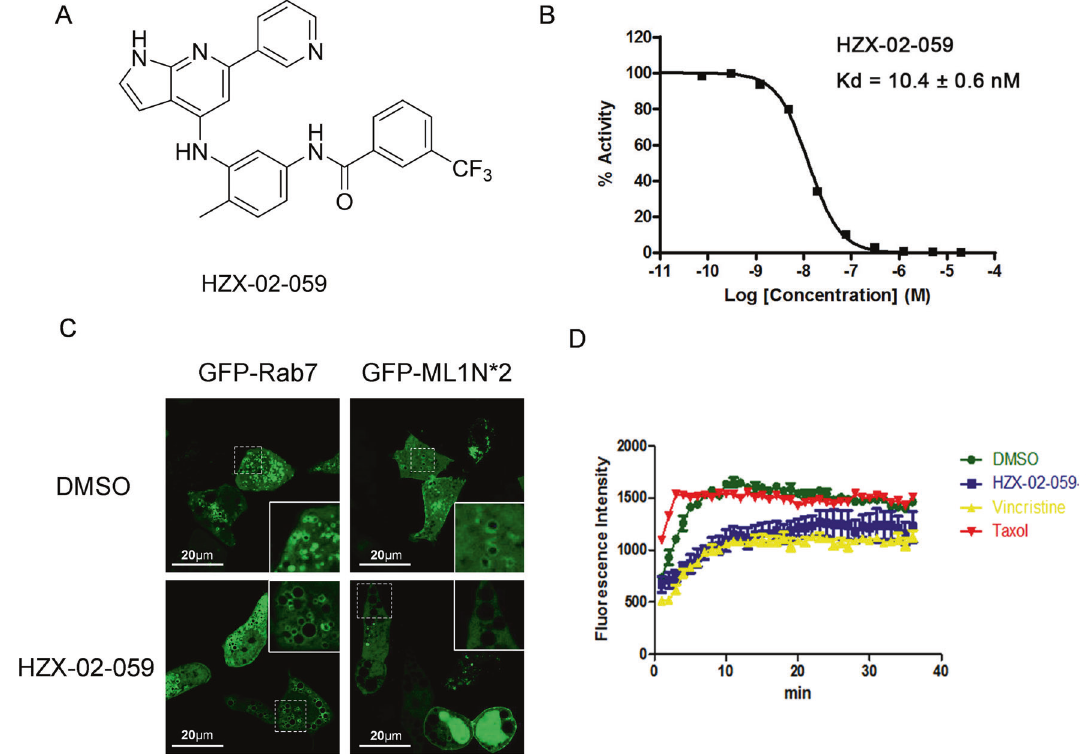
Fig. 1 HZX-02-059 is a PIKfyve and tubulin dual-target inhibitor. A The structure of HZX-02-059. B HZX-02-059 has a high af fi nity for PIKfyve with K d value of 10.4 ± 0.6 nM. Binding constant was detected by DiscoveRX Corporation, San Diego, CA. C HZX-02-059 reduced PI(3,5)P2 production and location on late endosome/lysosome membrane. 293T cells were transfected with GFP-Rab7 or GFP- ML1N*2 and then followed by 2 μ M HZX-02-059 treatment for 8 h. DMSO was used as a control. D HZX-02-059 suppresses tubulin polymerization. Tubulin polymerization was performed in vitro using a tubulin polymerization assay kit (Cytoskeleton, cat# BK011P). 100 μ M HZX-02-059 was used while Vincristine and Taxol were used as references with a concentration of 3 μ